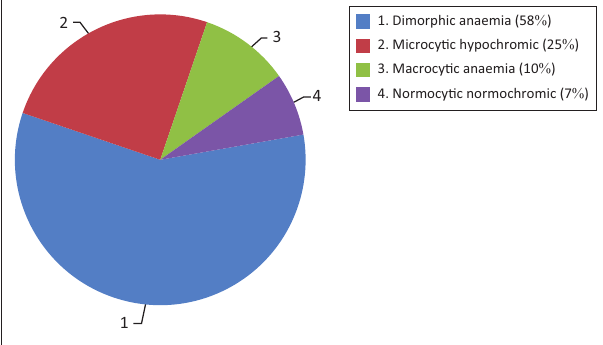
FIGURE 1: Distribution of morphological patterns of anaemia, Sudan, September 2016 to February 2017.